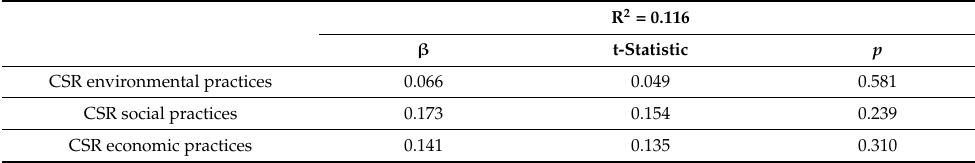
Table 5. Regression of the dependent variable-digitalization in relation to types of CSR.